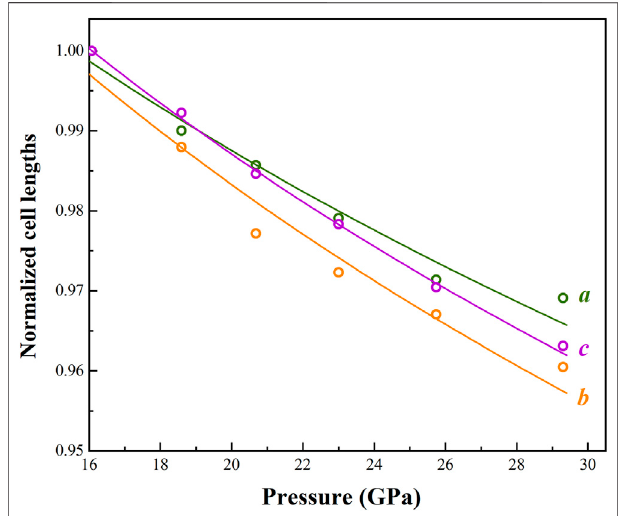
FIGURE 4 | Pressure dependence of normalized cell lengths (a, b and c) of monoclinic phase Cu 2 O. EoS fi ts in the current study are shown by solid